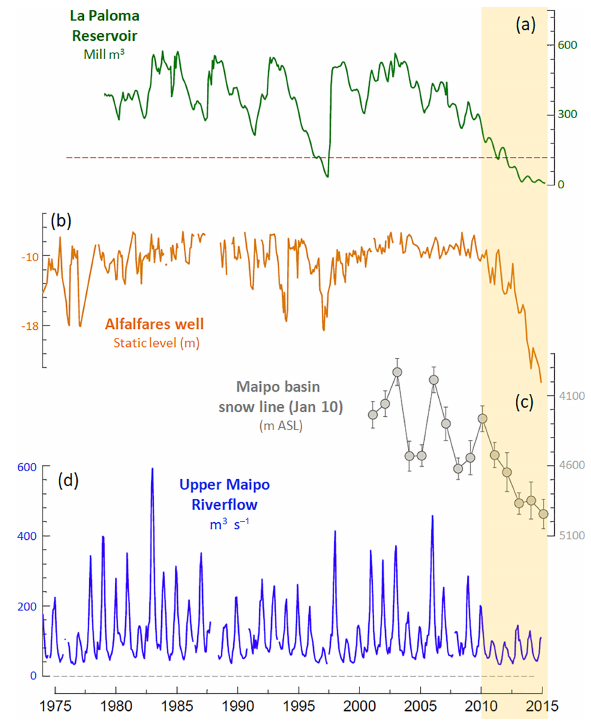
Figure 9. Selected hydrological impacts of the MD (highlighted by the yellow area). (a) Green curve: monthly mean water volume in the La Paloma reservoir (32 ◦ S). (b) Orange curve: monthly mean water depth in the Alfalfares observation well (32.5 ◦ S). (c) Grey curve: 10 January (early summer) height of the snowline between 33 and 34 ◦ S (note that the scale has been reversed). (d) Blue curve: monthly mean Maipo River flow as measures in station El Manzano (850ma.s.l., 33.5 ◦